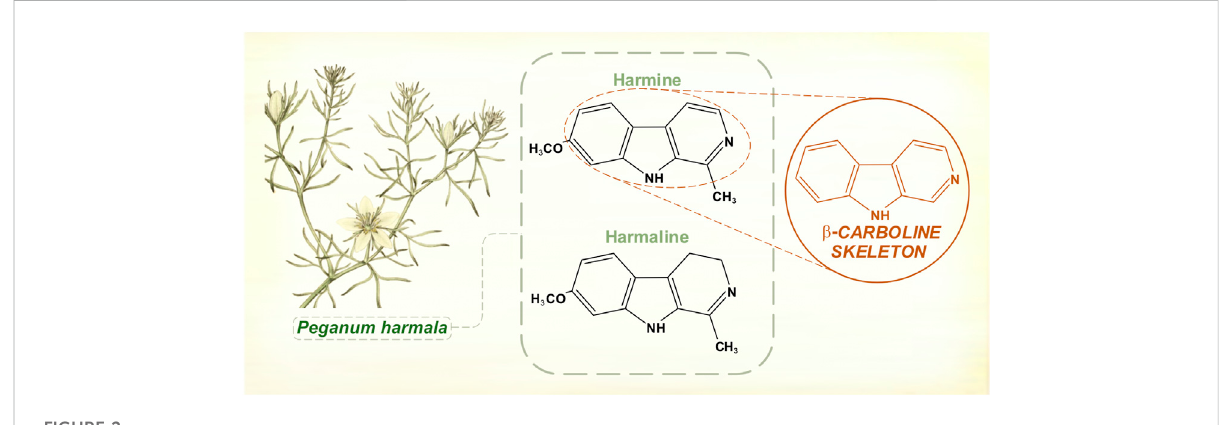
FIGURE 2 Hamalaalkaloidscontaina β -carbolinestructuralskeleton.Harmineandharmalinearereversibleinhibitorsofmonoamineoxidase(monoamine oxidase-A is selectively affected). [Illustration adapted from Bulliard (1780), available in the public